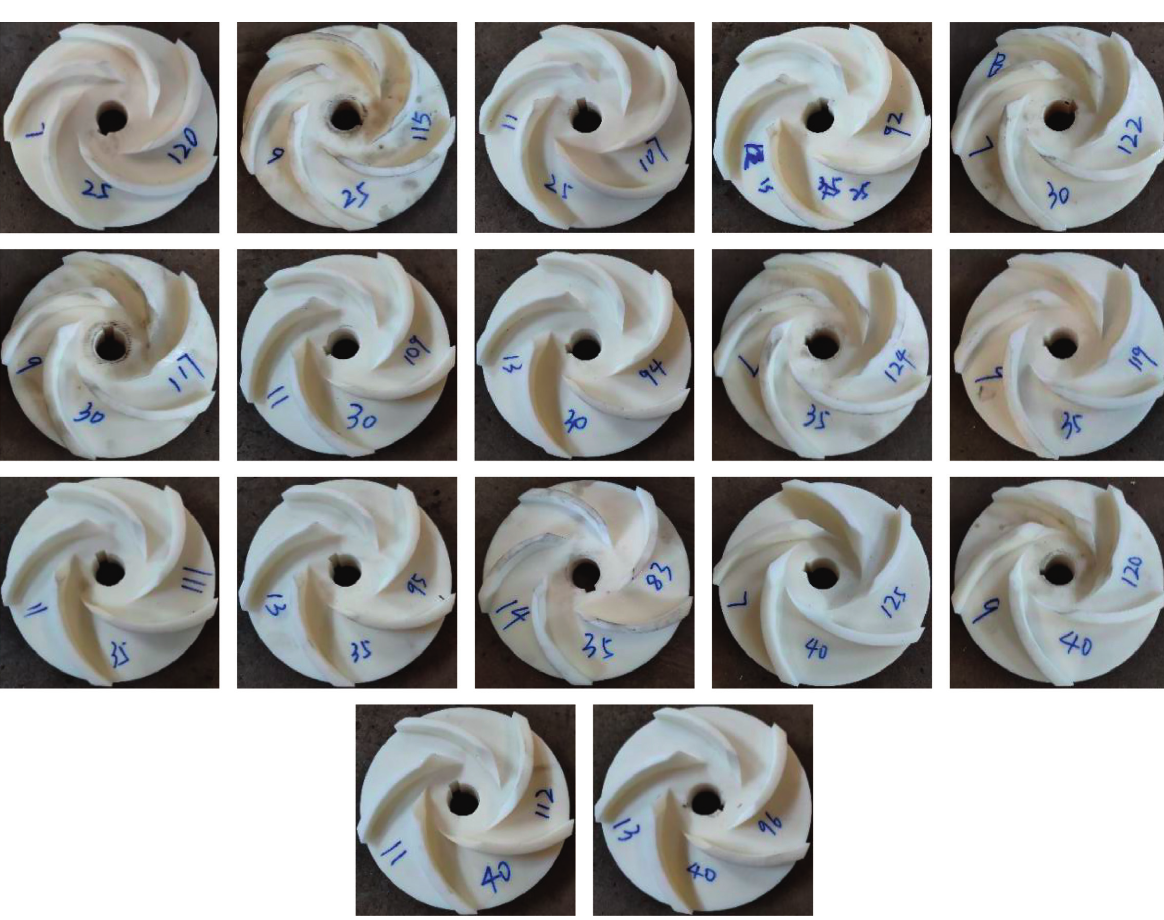
Figure 27: 3D printing impeller models of the impeller.